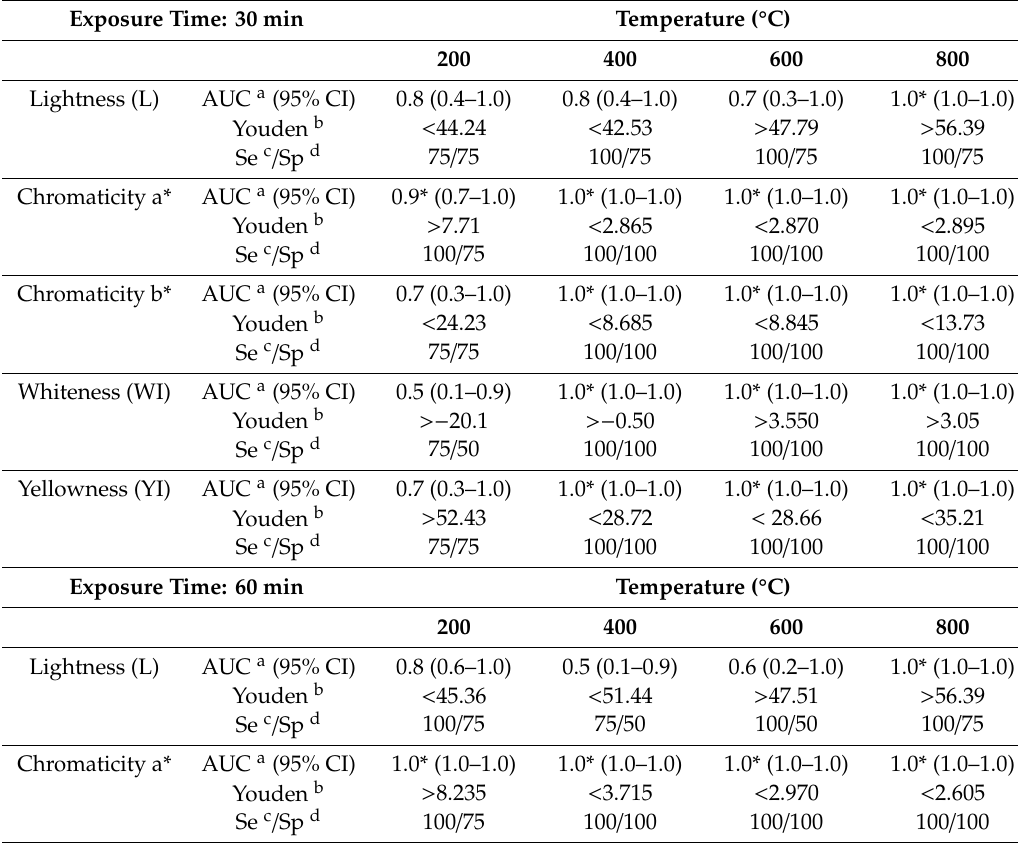
Table 1. Receiver Operating Characteristics (ROC) analysis predicting the temperature of burned cortical bone for 30 and 60 min with L, chromaticity a*, and chromaticity b* values and with whiteness (WI) and yellowness (YI)